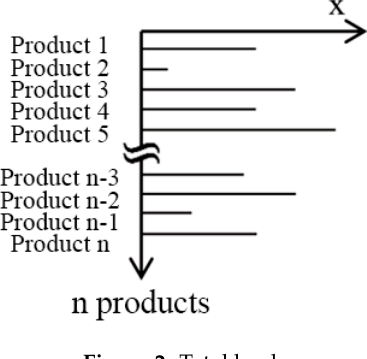
Figure 2. Total load.